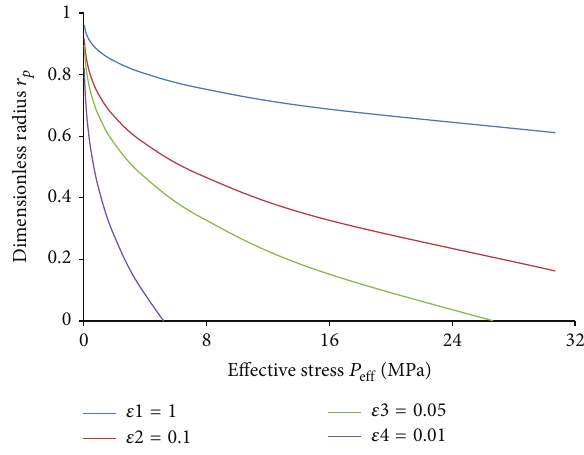
Figure 7: Effect of aspect ratio on star-shaped pores.